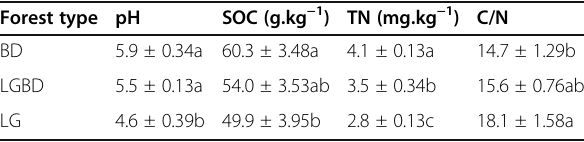
Table 1 Soil chemical and physical properties in three different forest